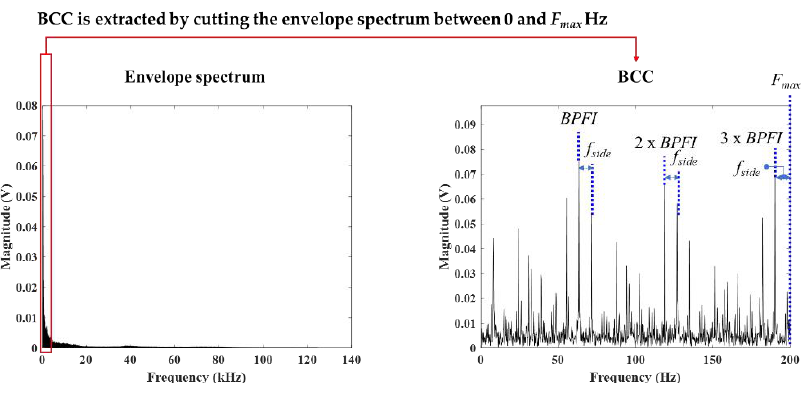
Figure 4. The extraction process of bearing characteristic components.